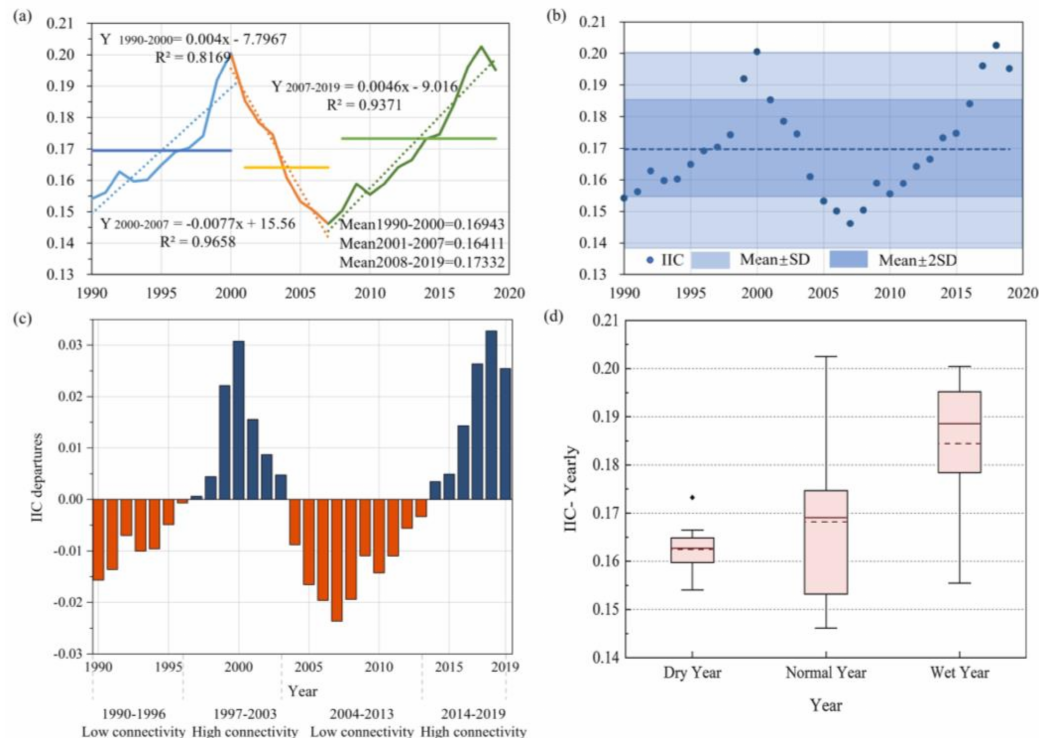
Figure 3. ( a ) Time series, trends, and staged changes of yearly-IIC of the Bosten Lake Basin from 1990–2019; ( b ) The discrete situation of IIC in the Bosten Lake Basin from 1990–2019; ( c ) IIC departures in the Bosten Lake Basin, 1990–2019, based on the average of 30-year period; ( d ) the distribution of yearly-IIC index in different years. The top and bottom of boxes represent the 75th and 25th percentiles, respectively, while the top and bottom whiskers represent the 90th and 10th percentiles, respectively. Solid red lines in the boxes are median values and dotted red lines represent mean